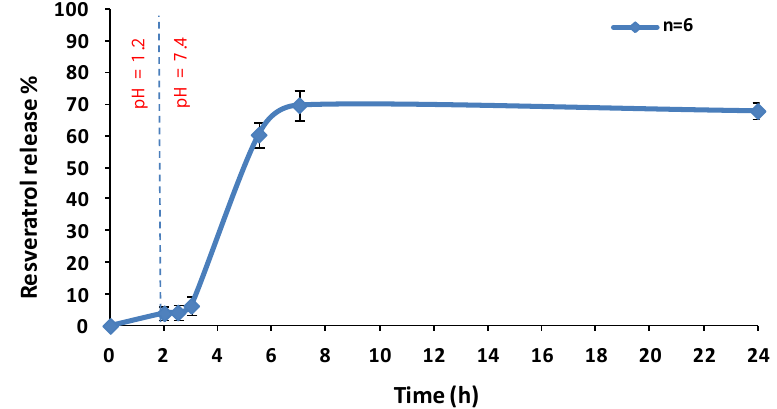
Figure 3. Percentage of resveratrol release from microparticles. The microparticles were dispersed in 750 mL of an acid medium (pH 1.2) for 2 h, followed by a basic medium (pH 7.4). Values represent the means ( n = 6 for each test) ± the standard error.